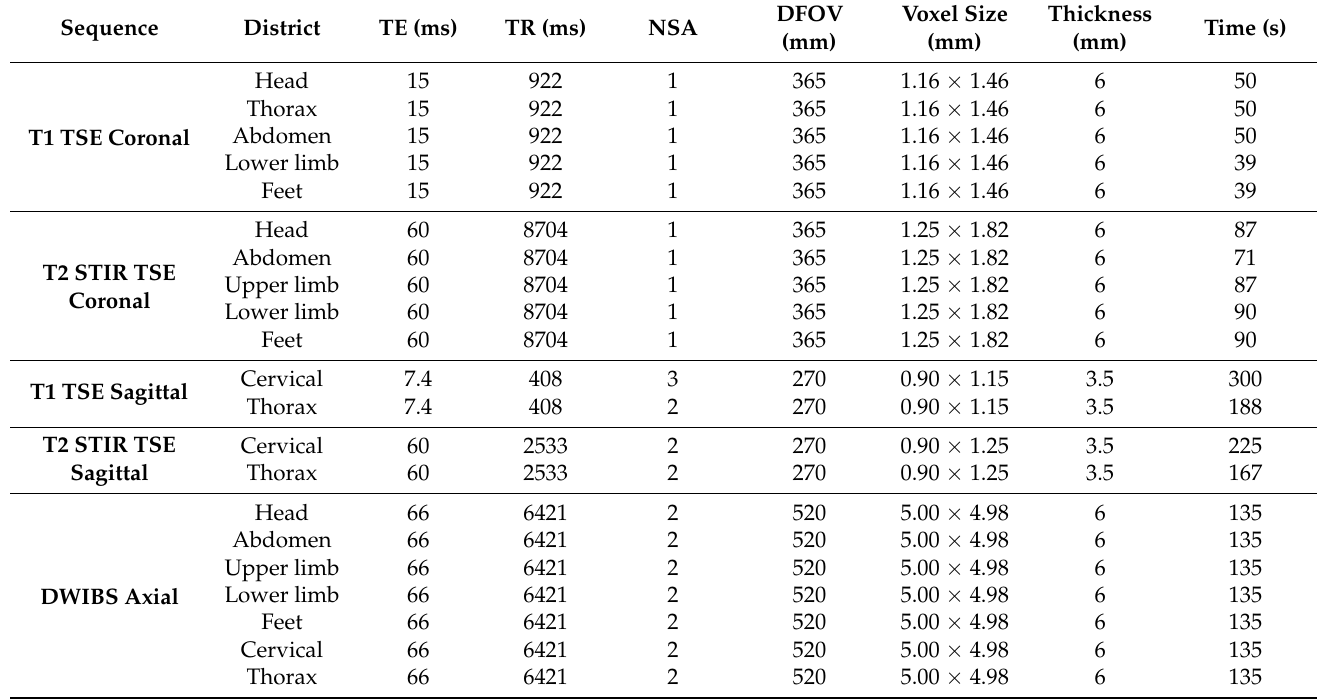
Table 1. Detailed scanning parameters for all